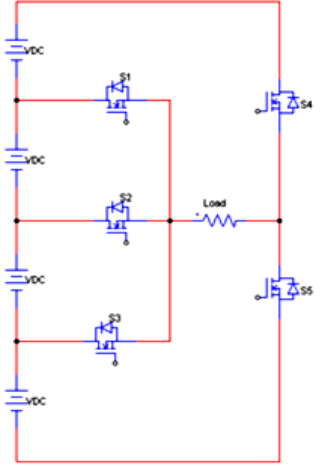
Figure 4. Circuit of seven-level five-switch inverter.